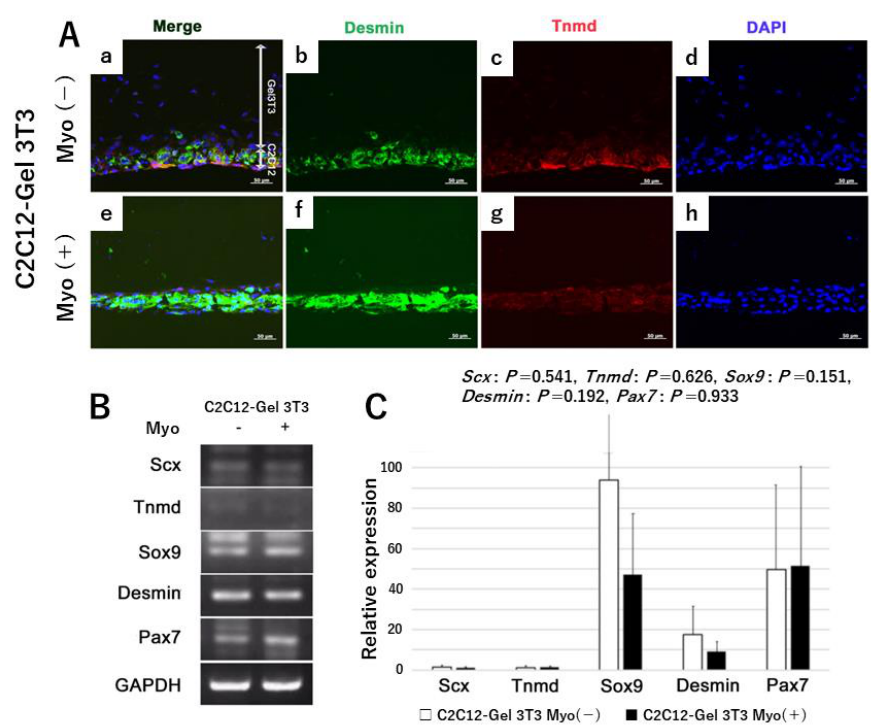
Figure 5. Expression of related proteins and genes in C2C12-Gel 3T3 sheets after 1 week of culture. ( Panel A ) ( a – h ) Immunohistochemical staining of C2C12-Gel 3T3. The upper row shows the Myo- free group (Myo( − )), while the lower row shows the Myo-added group (Myo(+)). Desmin and tenomodulin (Tnmd) were expressed in all myoblast sheets (Panels b,c,f,g). Dispersion of cell nuclei revealed by DAPI staining: in comparison to the Myo( − ) group, nuclei were regularly aligned in the Myo(+) group (Panels d,h). ( Panels B , C ) Expression of related genes Scx, Tnmd, Sox9, desmin, and Pax7: no difference in expression level was evident between Myo( − ) and Myo(+) ( n =